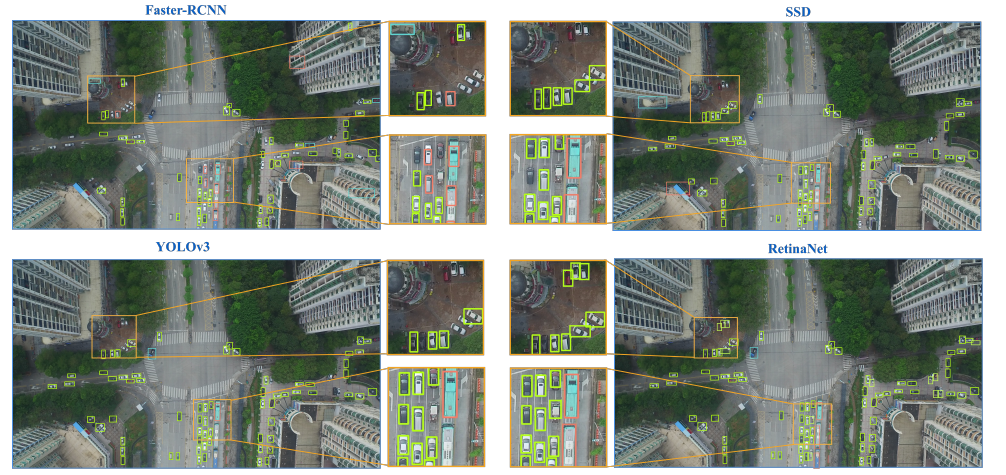
Figure 8. The qualitative result of vehicle detection on a testing image.